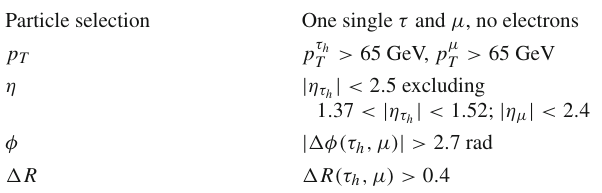
Table 5 Summary of the experimental cuts for the ATLAS τ h μ search [46] Particle